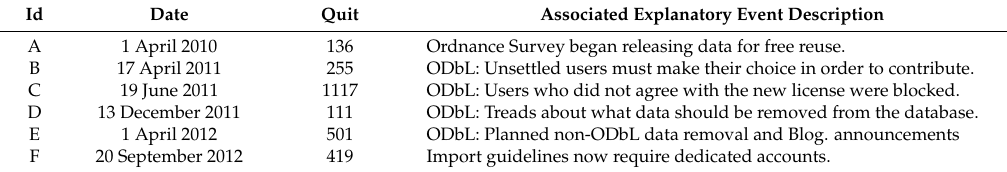
Table 3. Outstanding random variations of withdrawals from OSM with associated explanatory events. ‘Id’ refers to the labels of Figure 6. ‘Quit’ is the estimated number of withdrawn